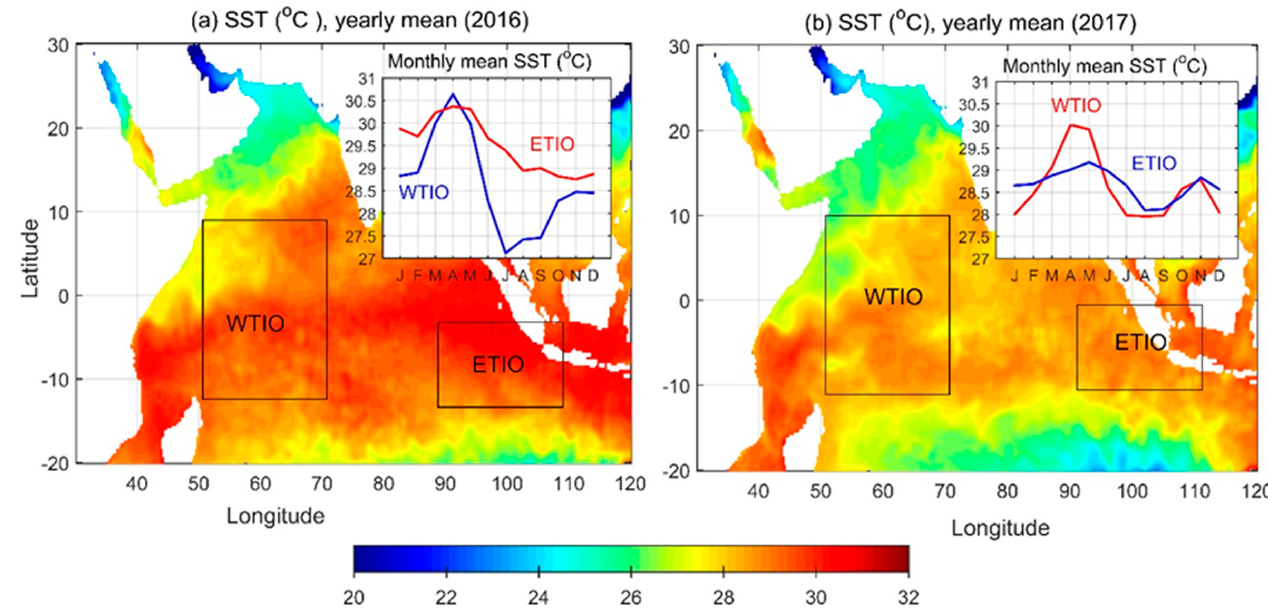
Figure 6. Yearly mean SST in the TIO based on NOAA OISSTv2.0 for 2016 ( a ) and 2017 ( b ). Monthly mean SST cycle of the WTIO and ETIO regions is depicted on the map.